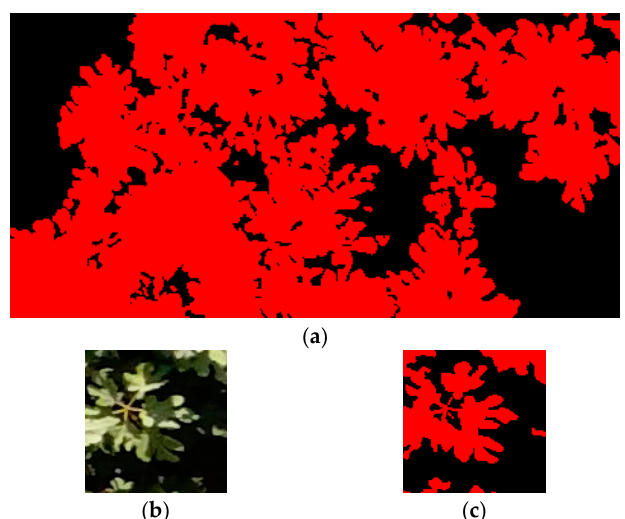
Figure 2. Views of image regions manually labelled: ( a ) Labelled image segment (400 × 200 pixels), the labelled pixels are represented in red colour; ( b ) and ( c ) Zoom view of a small region (112 × 112 pixels) which shows the level of detail of the labelling process.